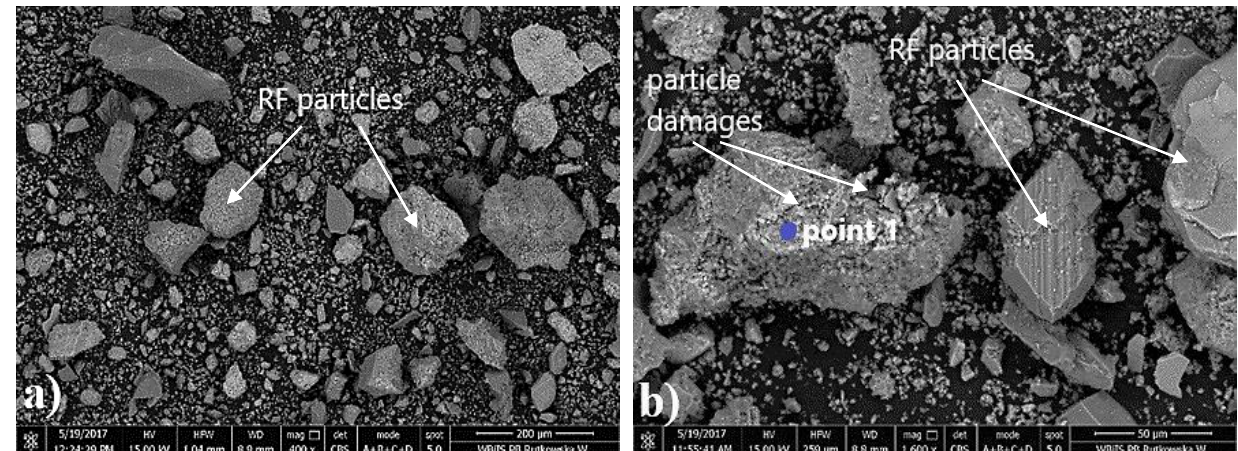
Figure 5. SEM observations of recycled fines calcined at 650 ° C (Magnification: ( a ) left: ×400, ( b )right: ×1600).